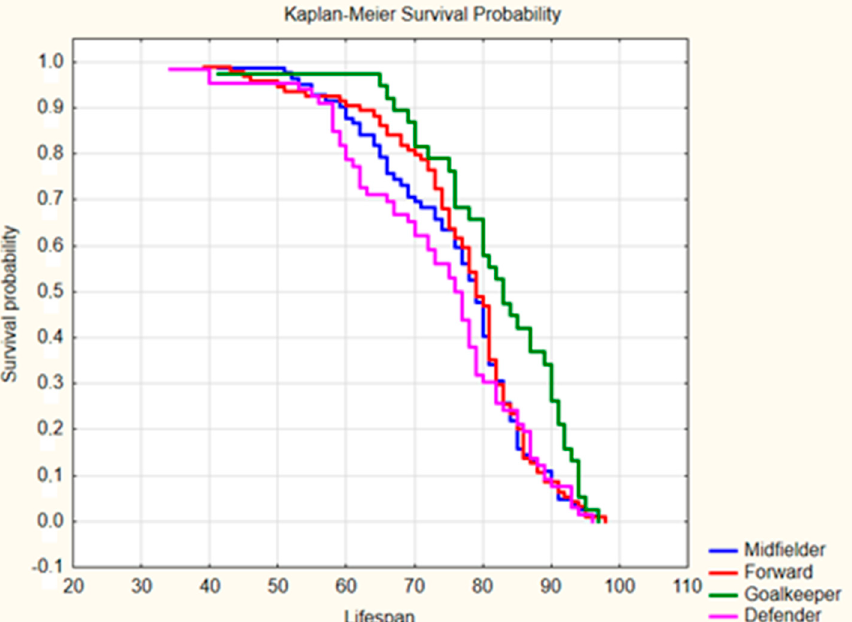
Figure 2. Kaplan–Meier survival probability curves for players playing for leading clubs in the top European leagues during the season 1946 / 1947. Source: self-calculated data based on www.